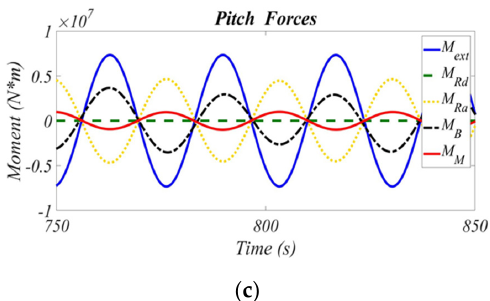
Figure 16. Time histories of wave-load components at ( a ) the surge natural frequency ( f p = 0.008 Hz), ( b ) the heave natural frequency ( f p = 0.032 Hz), and ( c ) the pitch natural frequency ( f p = 0.037 Hz)